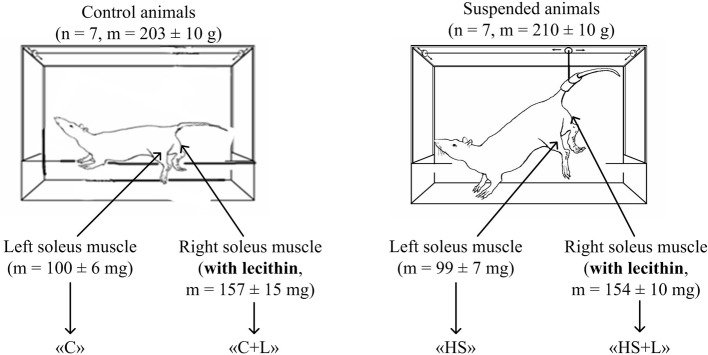
Experimental design.